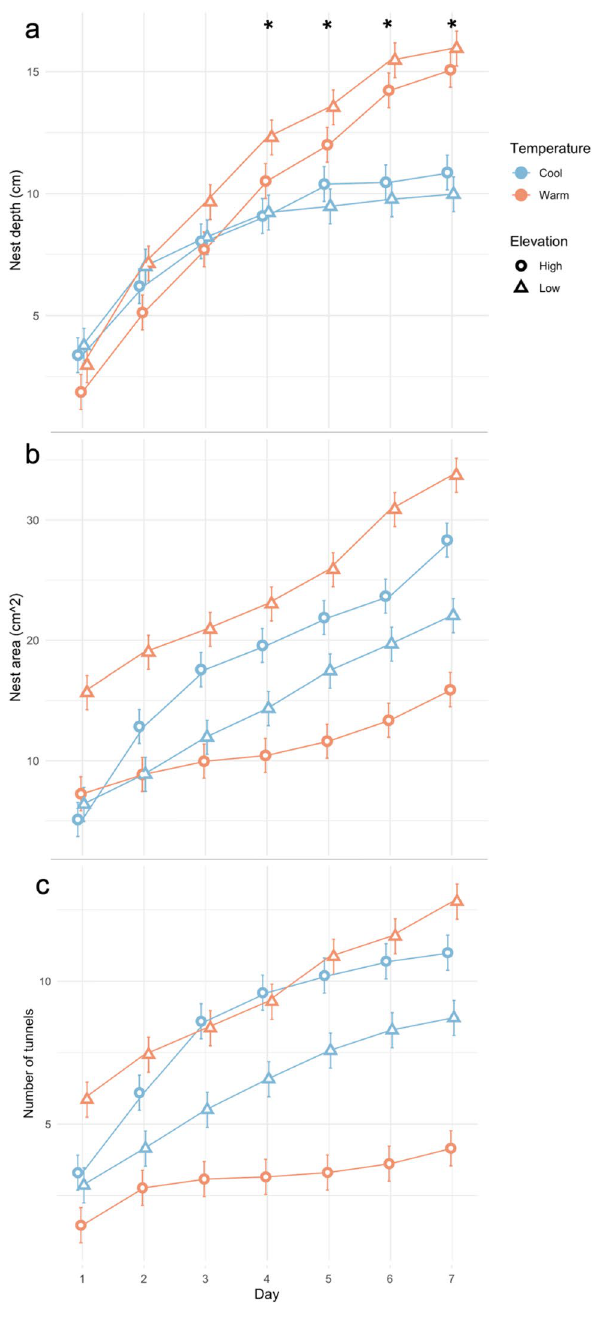
Figure 4. Excavation progress in terms of mean nest depth ( a ), total area ( b ), and the number of tunnels ( c ) throughout the 7-day trials. Error bars represent standard error. *Significant difference between temperature